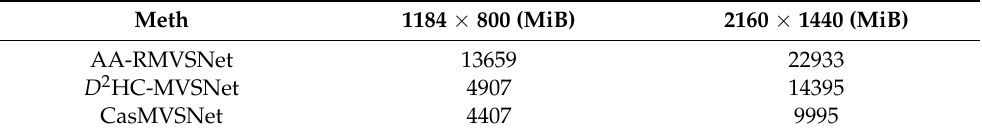
Table 3. Memory consumption of various deep learning methods in different sizes of